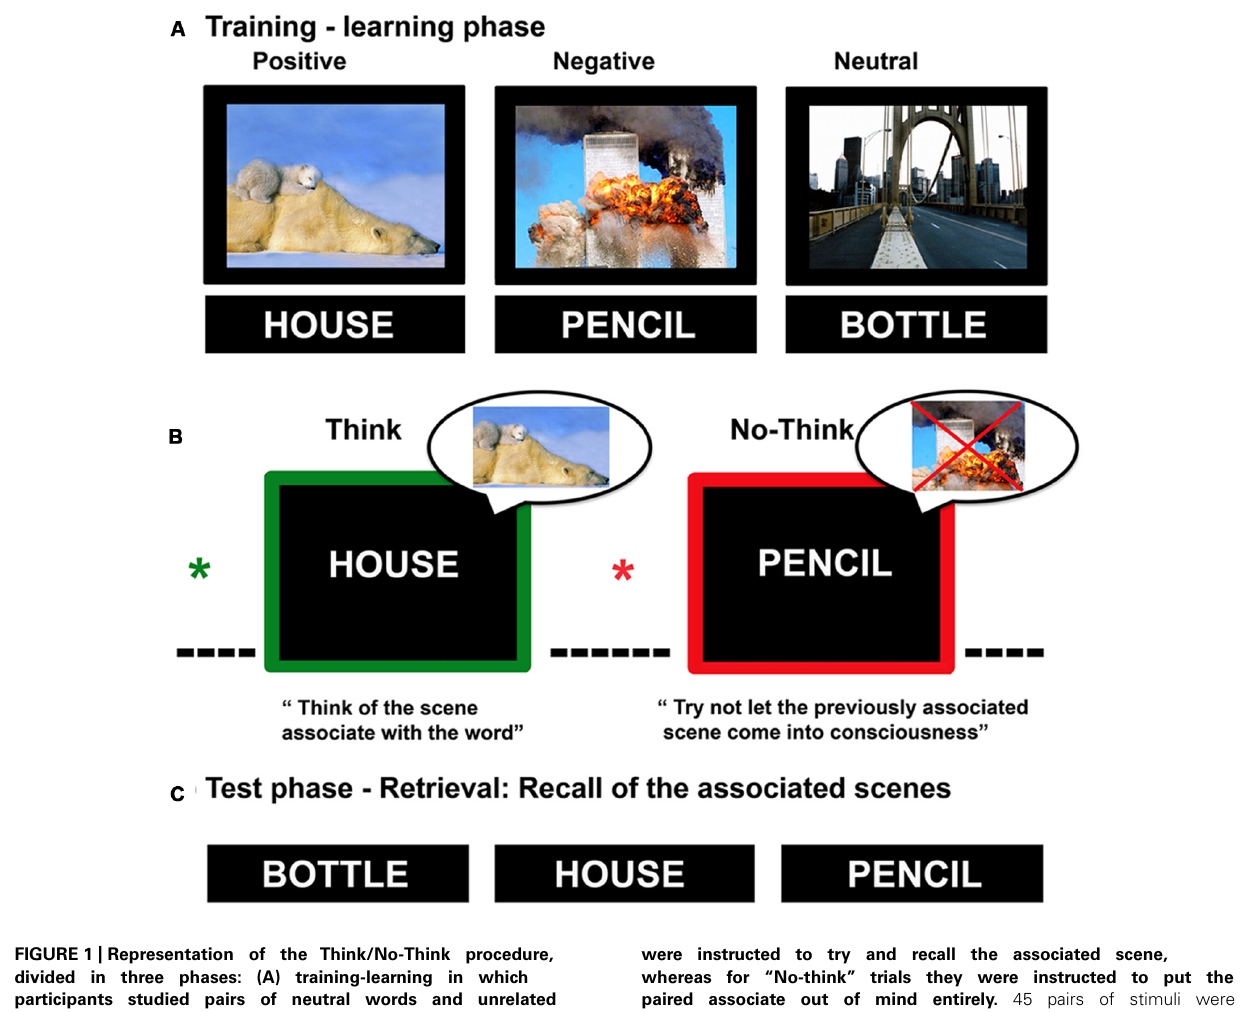
were instructed to try and recall the associated scene, whereas for “No-think” trials they were instructed to put the paired associate out of mind entirely. 45 pairs of stimuli were not presented during the Think/No-think phase because they served as baseline; (C) participants were asked to recall the scene associated with the presented word-cue. (Images of scenes were taken from IAPS, Lang etal.,